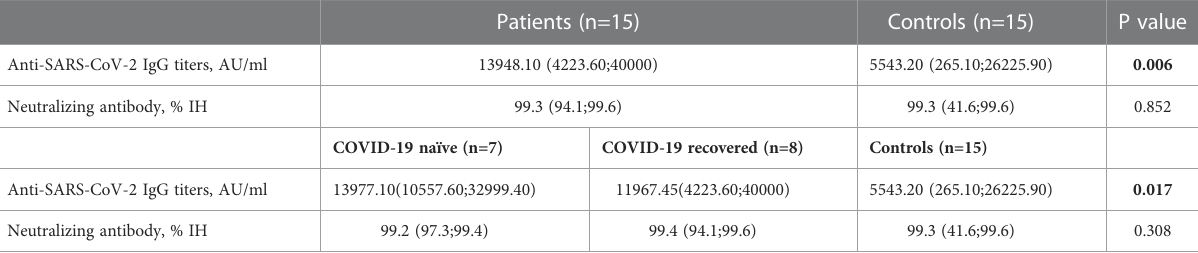
TABLE 2 Comparison of Anti-SARS-CoV-2 IgG titers and neutralizing antibody IH% activity between patients with inborn errors of metabolism and control subjects after the second dose of BNT162b2 vaccination. Patients